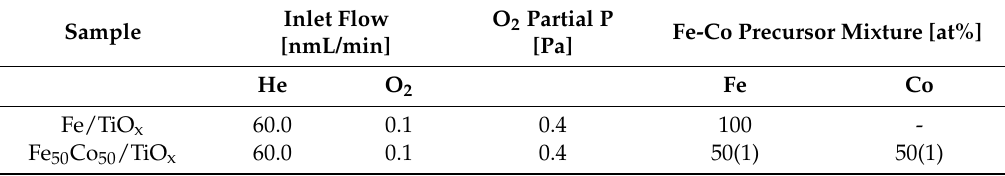
Table 3. Gas flow and O 2 partial pressure during the synthesis of Fe-Co/TiO x NCs. The total pressure was 260 Pa. The Co and Fe content in the mixed powder precursor are reported.